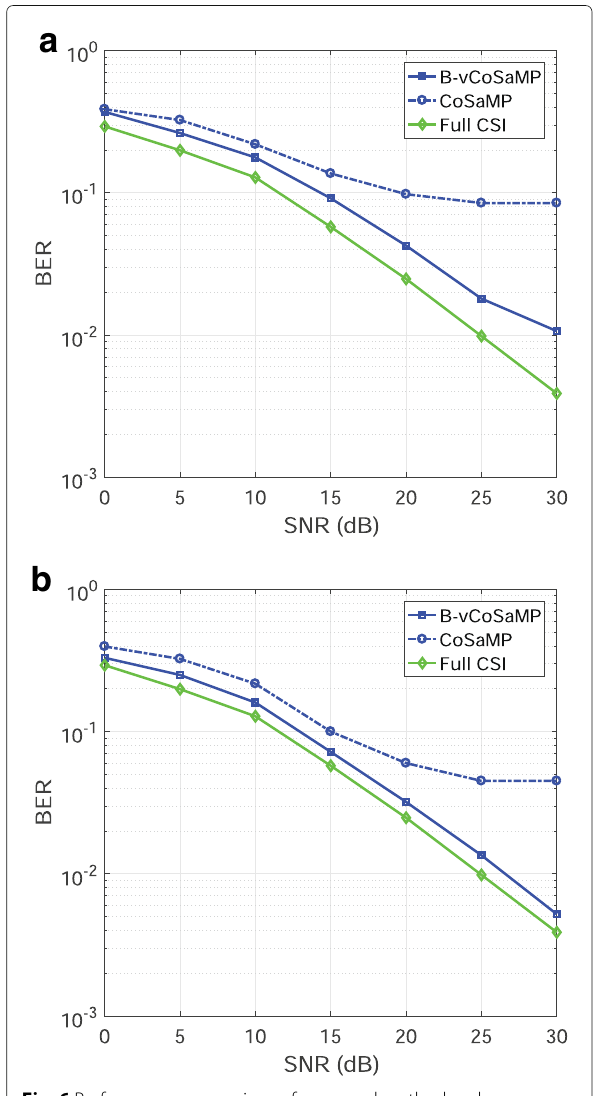
Fig. 6 Performance comparison of proposed method and CoSaMP-based channel estimation algorithm. a BER performance using random pilot allocation and b BER performance using optimized PCE-based pilot